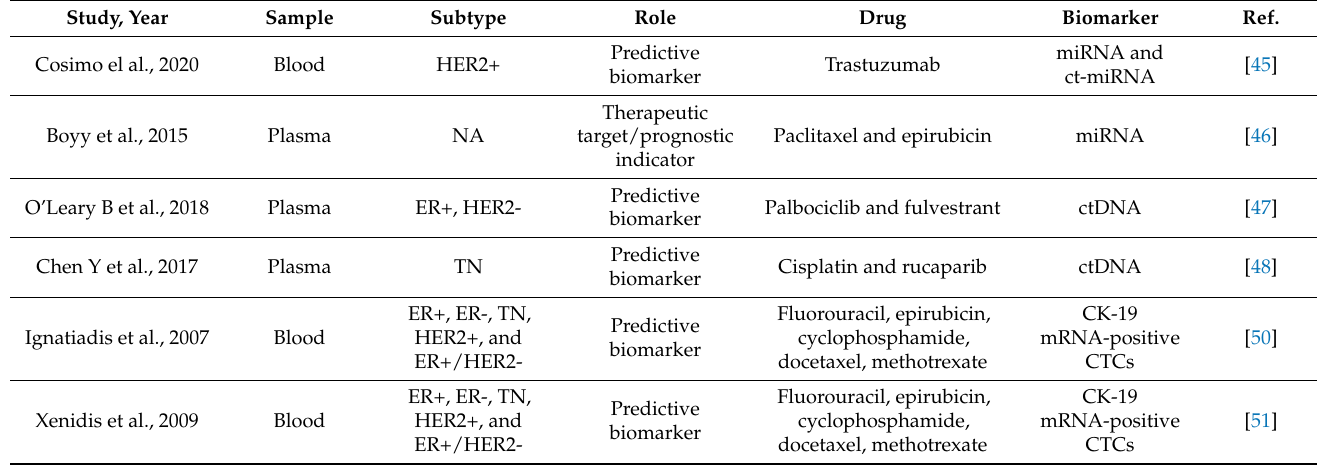
Table 2. Summary of studies demonstrating the use of liquid biopsy to aid in drug